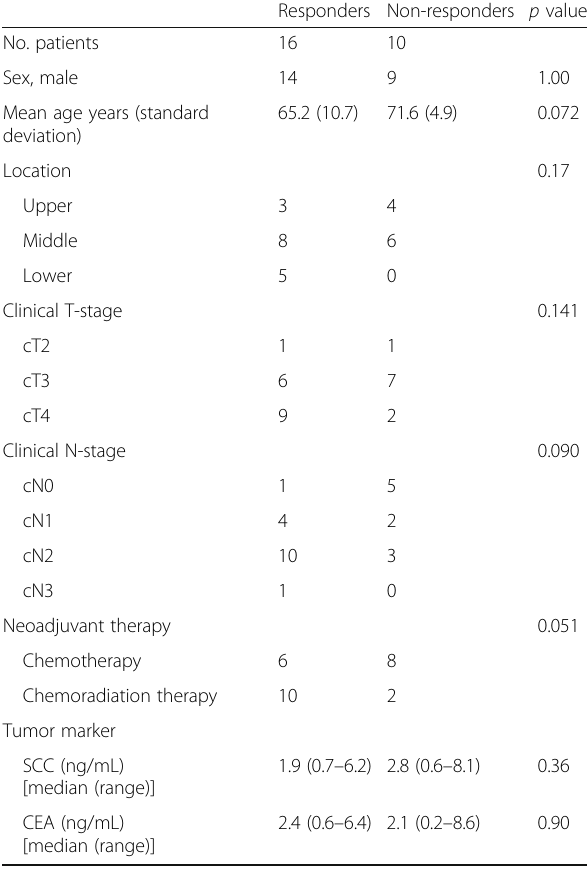
Table 2 Clinicopathologic characteristics comparing between responders and